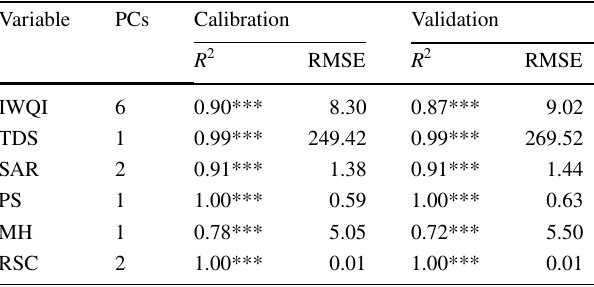
Table 6 Calibration and validation models results of PLSR for the association between measured and predicted for IWQI, TDS, SAR, PS, MH, and RSC across pooled data